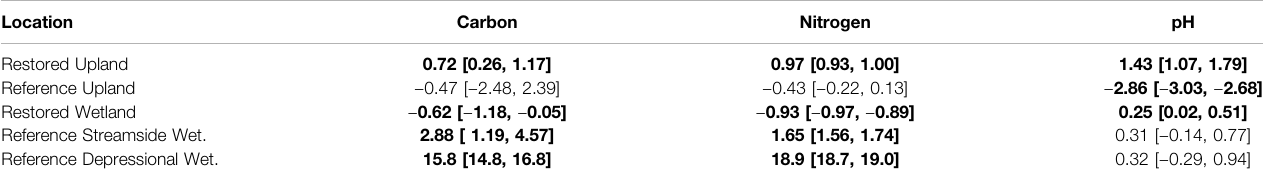
TABLE2| StandardizedmeaneffectsizesCohen ’ s d and95%con fi denceintervals(CI)forthein fl uenceofnitrogen- fi xingplantsin fi velocationonbulksoilcarbon,nitrogen, and pH.